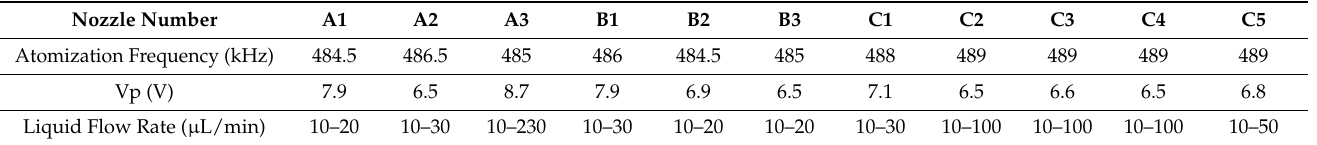
Table 1. Comparison of nozzle and atomization parameters. Vp shown is based on the best conditional atomization. Liquid flow rates were carefully adjusted to determine the potential operating